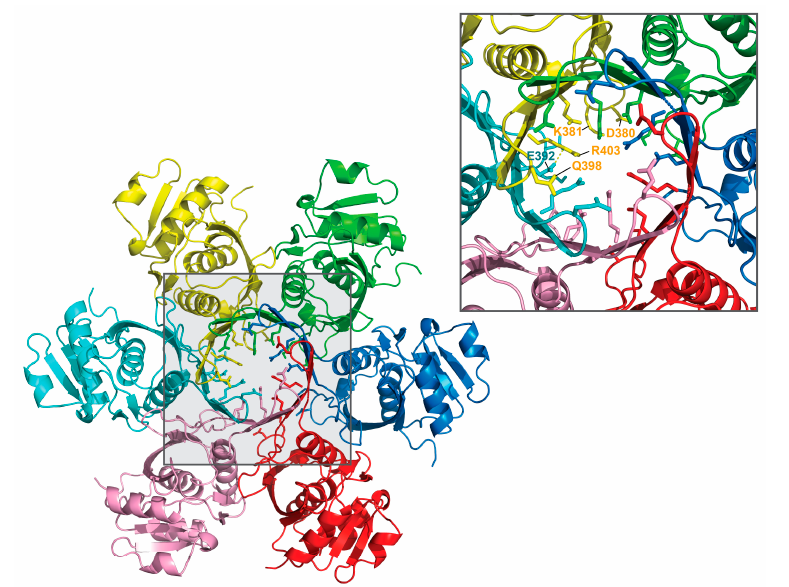
Figure 5. Hexamer of the protease domain of Bs LonBA (top view). Top view of the central chamber of the P domain with protruding side chains of the residues in an extended conformation (shown in sticks).